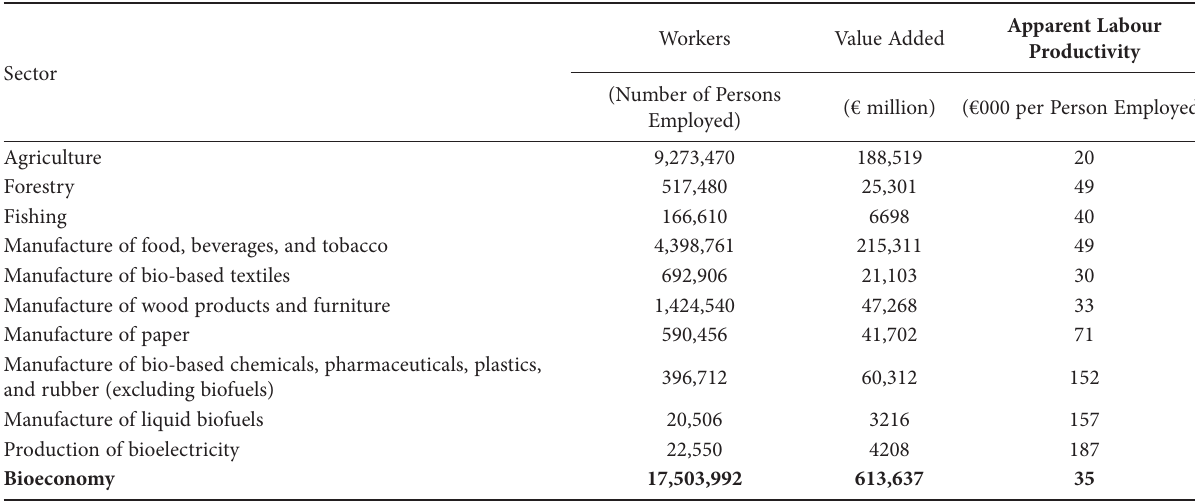
Table 1. Number of persons employed, value added, and apparent labour productivity by sector of the Bioeconomy (EU-27, 2017). (Ronzon et al.,